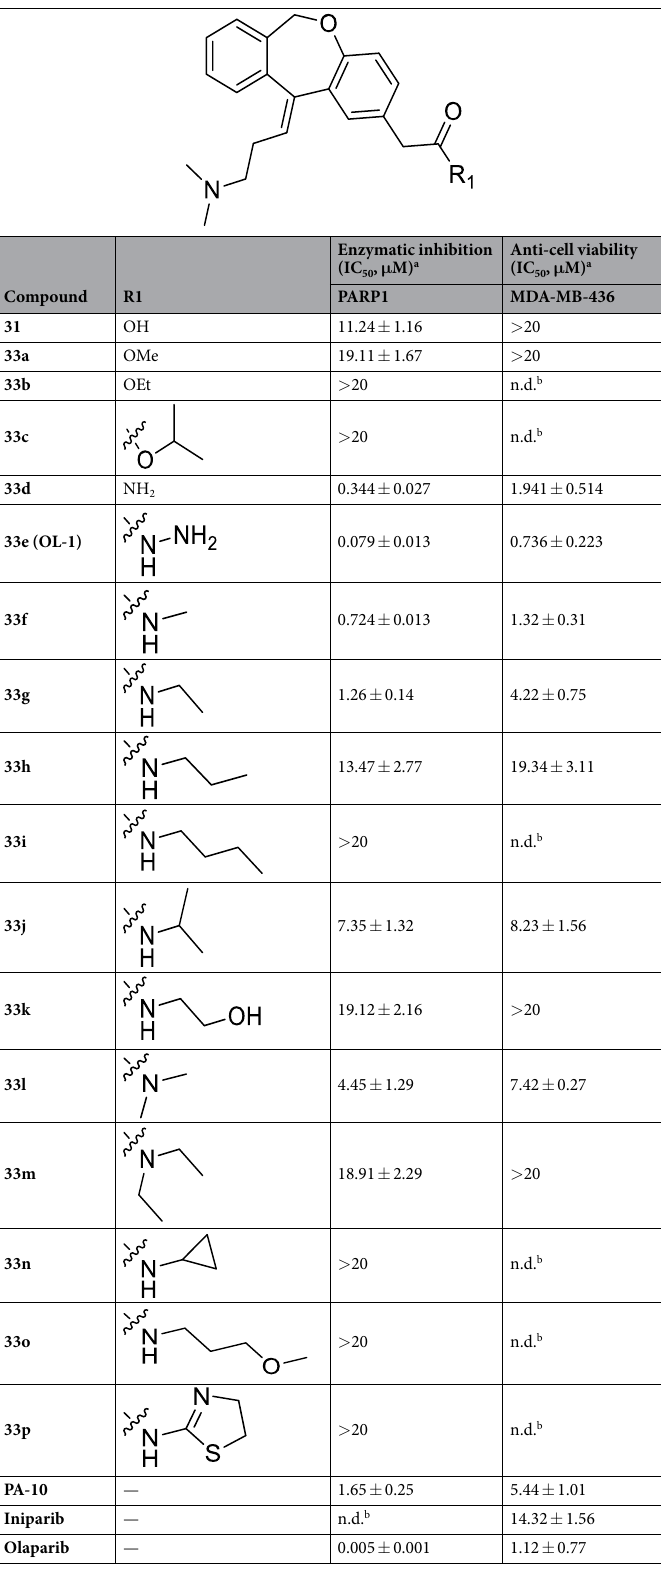
Table 6. Inhibition Data of compounds 31 and 33 against Recombinant Human PARP1 and MDA-MB-436 cells. a The IC 50 values are presented as mean ± SD, which is determined by at least three independent experiments. b The n.d. means data are not